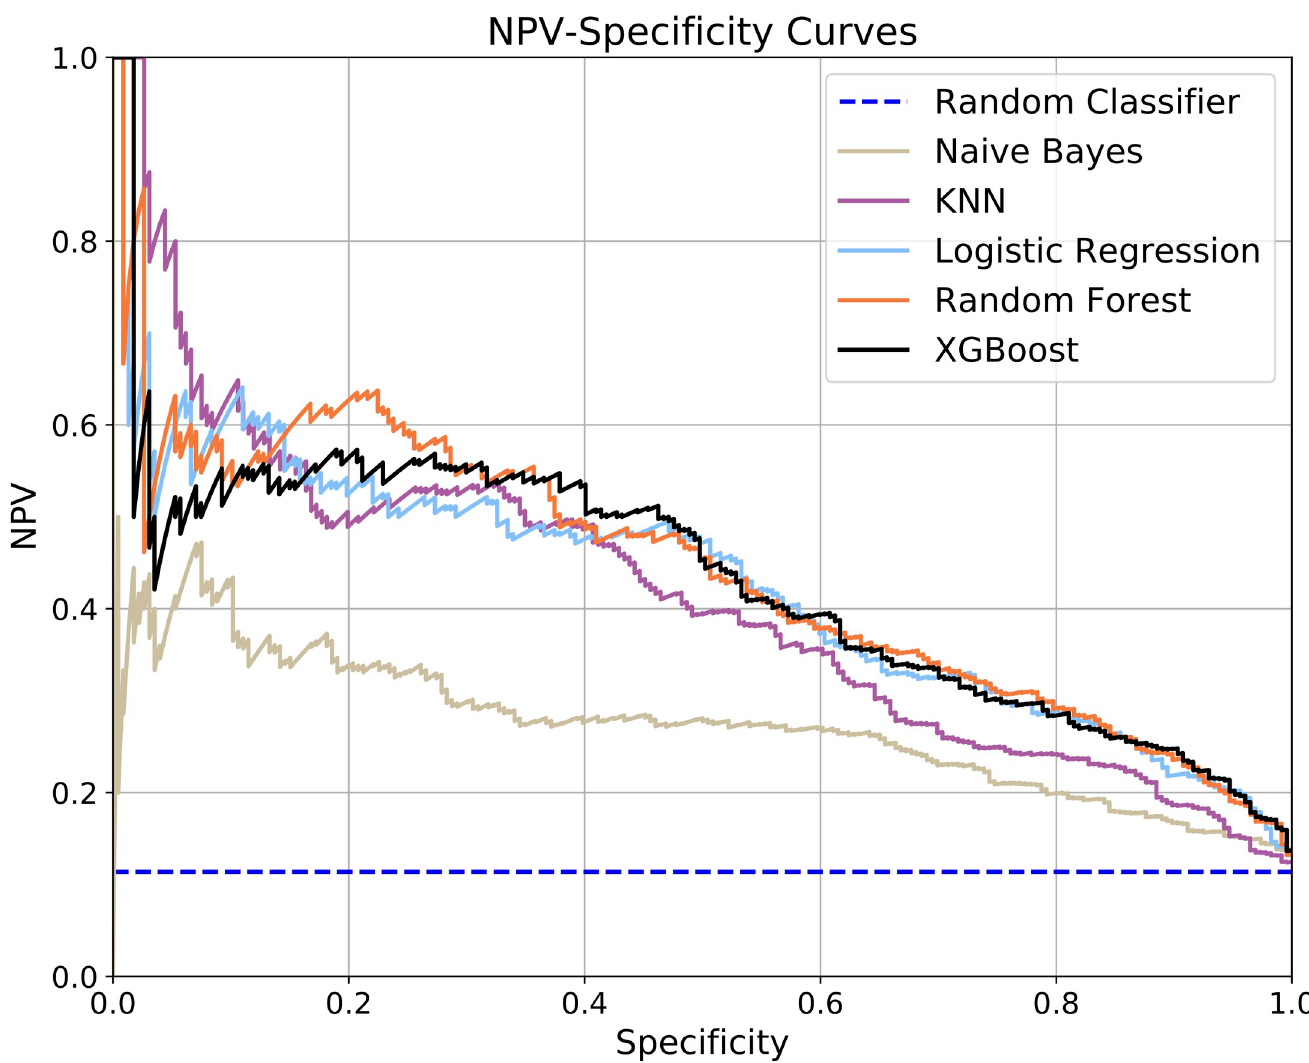
Fig 4. NPV-specificity curves. The curves correspond to the validation fold that yielded the median ANSA.